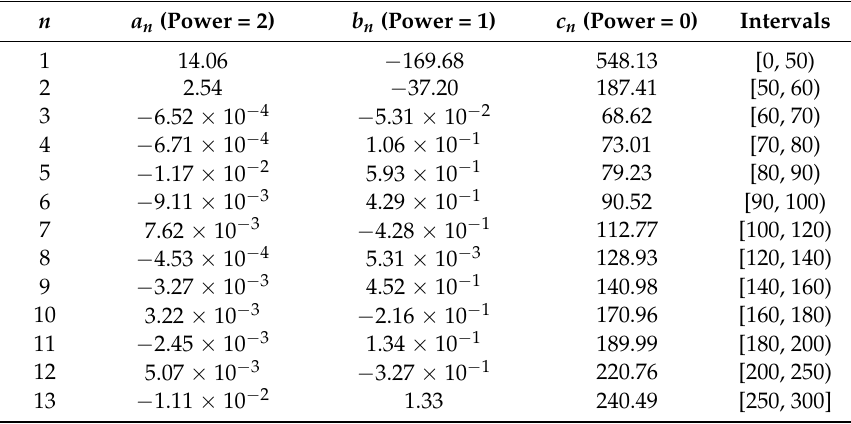
Table 3. Piecewise function coefficients for the S-TBV